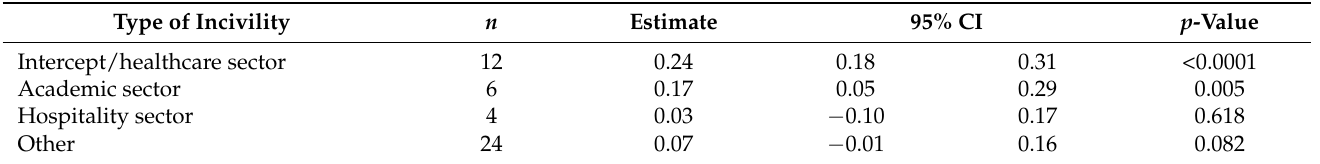
Table 4. Meta-regression analysis for industry